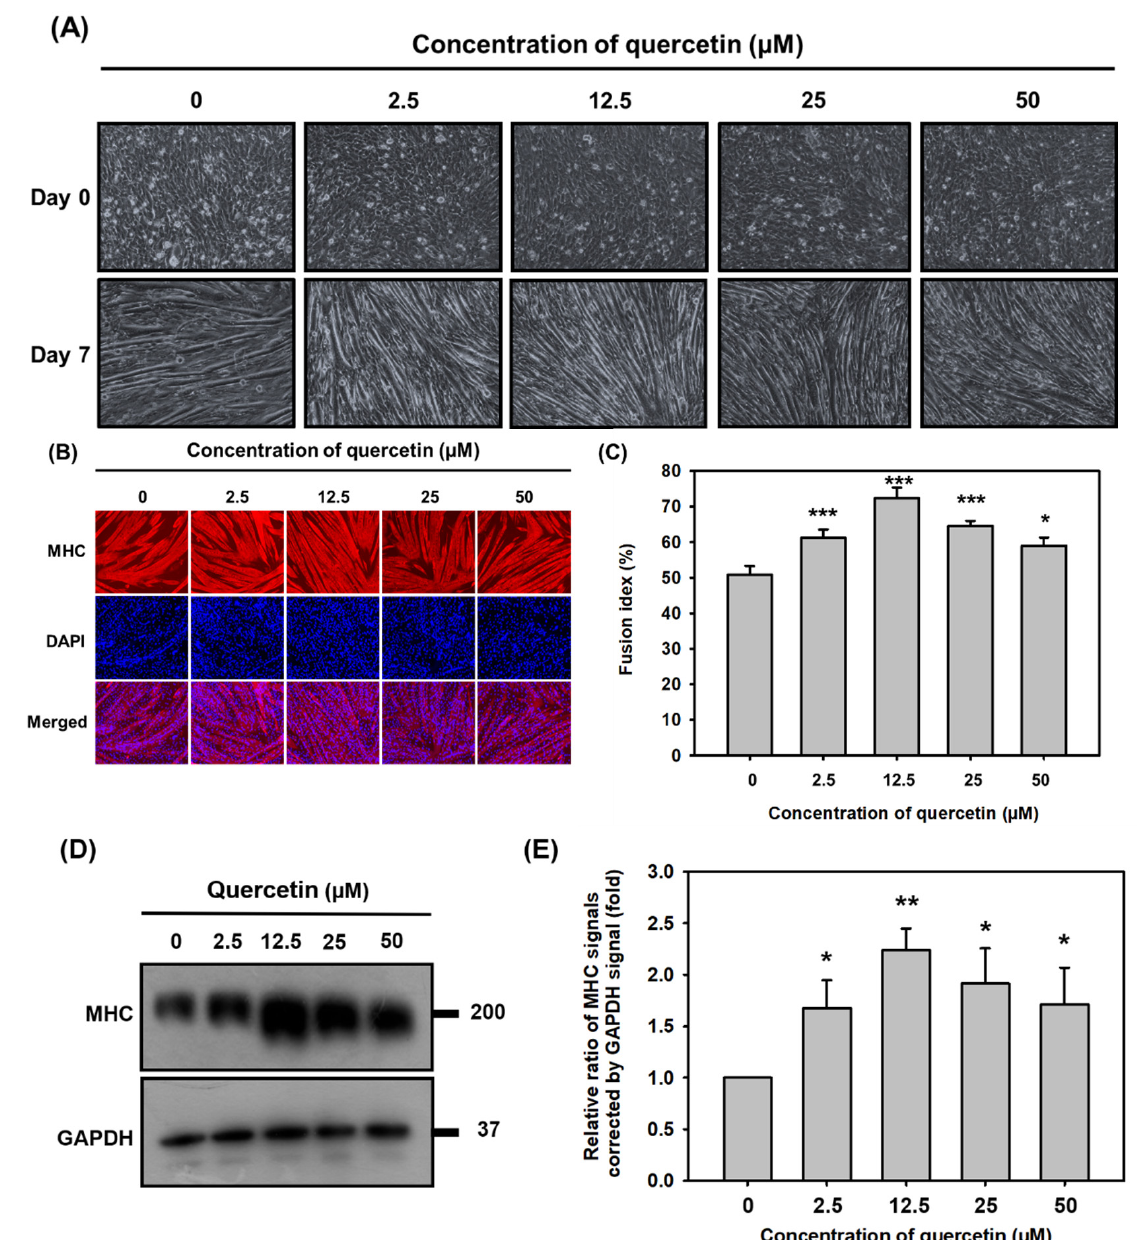
Figure 2. Quercetin significantly promoted myoblast fusion and myogenic differentiation. C2C12 cells were grown to 80% confluency density in a 24-well plate, in wells treated with varying amounts of quercetin (0, 2.5, 12.5, 25, 50 μ M), and cultured with DMEM medium containing 2% horse serum to promote cell differentiation. ( A ) C2C12 myoblasts changed to myotubes after 7 days of quercetin treatment. ( B ) Following 7 days of differentiation, C2C12 cells were stained for MHC and DAPI to determine the fusion index (percent nuclei in MHC-positive cells). ( C ) Image J was used to calculate the fusion index, the bar chart showing the fusion index following treatment for 7 days with or without quercetin. Western blot was used to analyze the expression of MHC protein, with GAPDH used as internal control. ( D ) Western blot images and ( E ) bar graph show protein expression of MHC relative to GAPDH. Data are expressed as mean ± SD based on three independent biological repeats ( n = 3). The differences were significant, expressed as * p < 0.05, ** p < 0.01, *** p < 0.001.